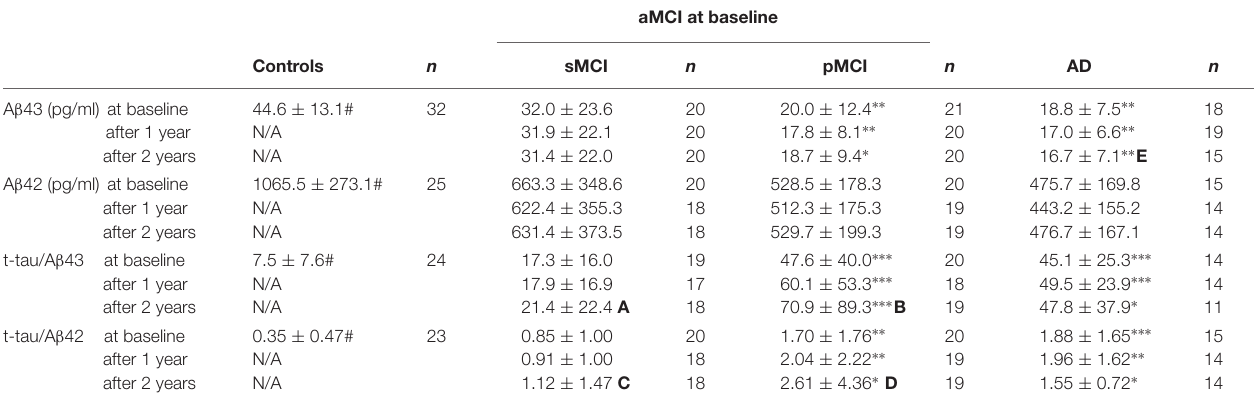
TABLE 2 | Cerebrospinal fluid (CSF) biomarker data.